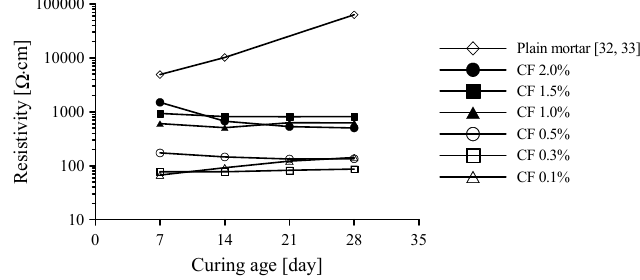
Figure 5. Effect of amounts of CFs for electrical resistivity with ages.